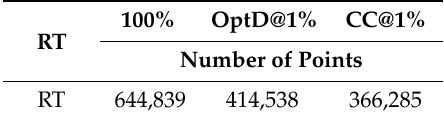
Table 8. E ff ect of data reduction on RT